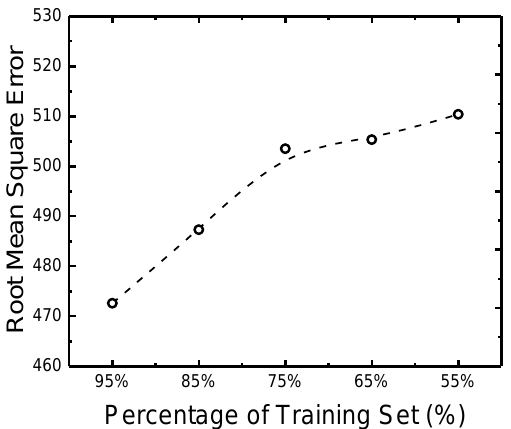
Figure 2. Average root mean square errors (RMS errors) of the testing processes with the training sets percentage varying from 55% to 95%. The training with each percentage was repeated 200 times.